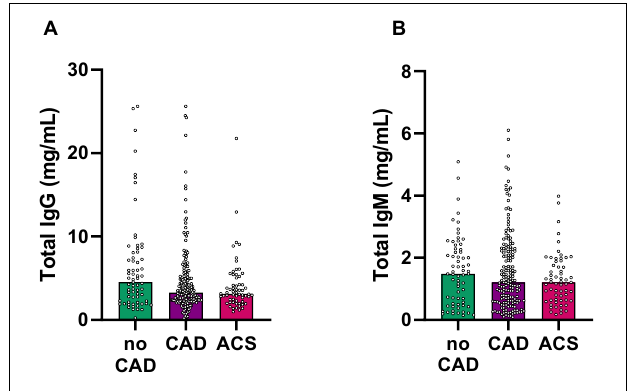
FIGURE 2 | Total IgG and IgM plasma levels do not associate with coronary atherosclerosis in coronary angiography. (A) Total IgG and (B) IgM levels